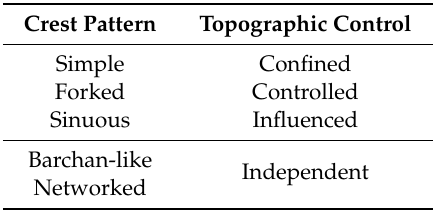
Figure 12. Site F275 ‐ 276 (175.615°, − 14.633°, Projection GCS_Mars). ( a ) Full resolution image (25 cm / pixel). TAR spacing in image pixels approximates MINDTCT input fingerprint ridge spacing. ( b ) Defect extraction. Color key same as Figure 10. Radiating lines represent defect orientation. Table 2. TAR classification system [100,101]. Site L09 ‐ 10 (Figure 13a) is a TAR field within a double crater with a low dividing ridge. TAR spacing is ~2.75 m which is equal to ~13 pixels at the raw image resolution. Unlike the relatively